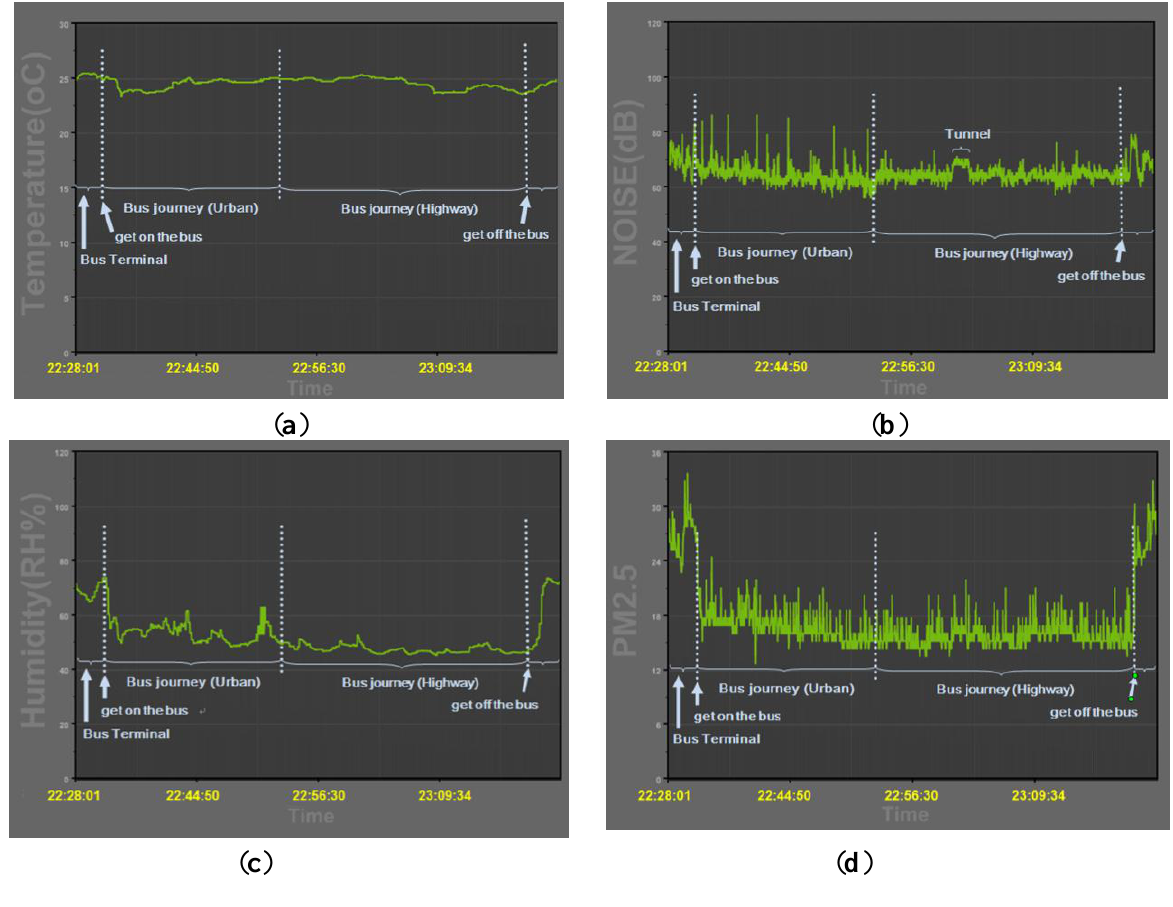
Figure 14. Achieve data of ( a ) temperature; ( b ) humidity; ( c ) sound level; ( d ) PM 2.5